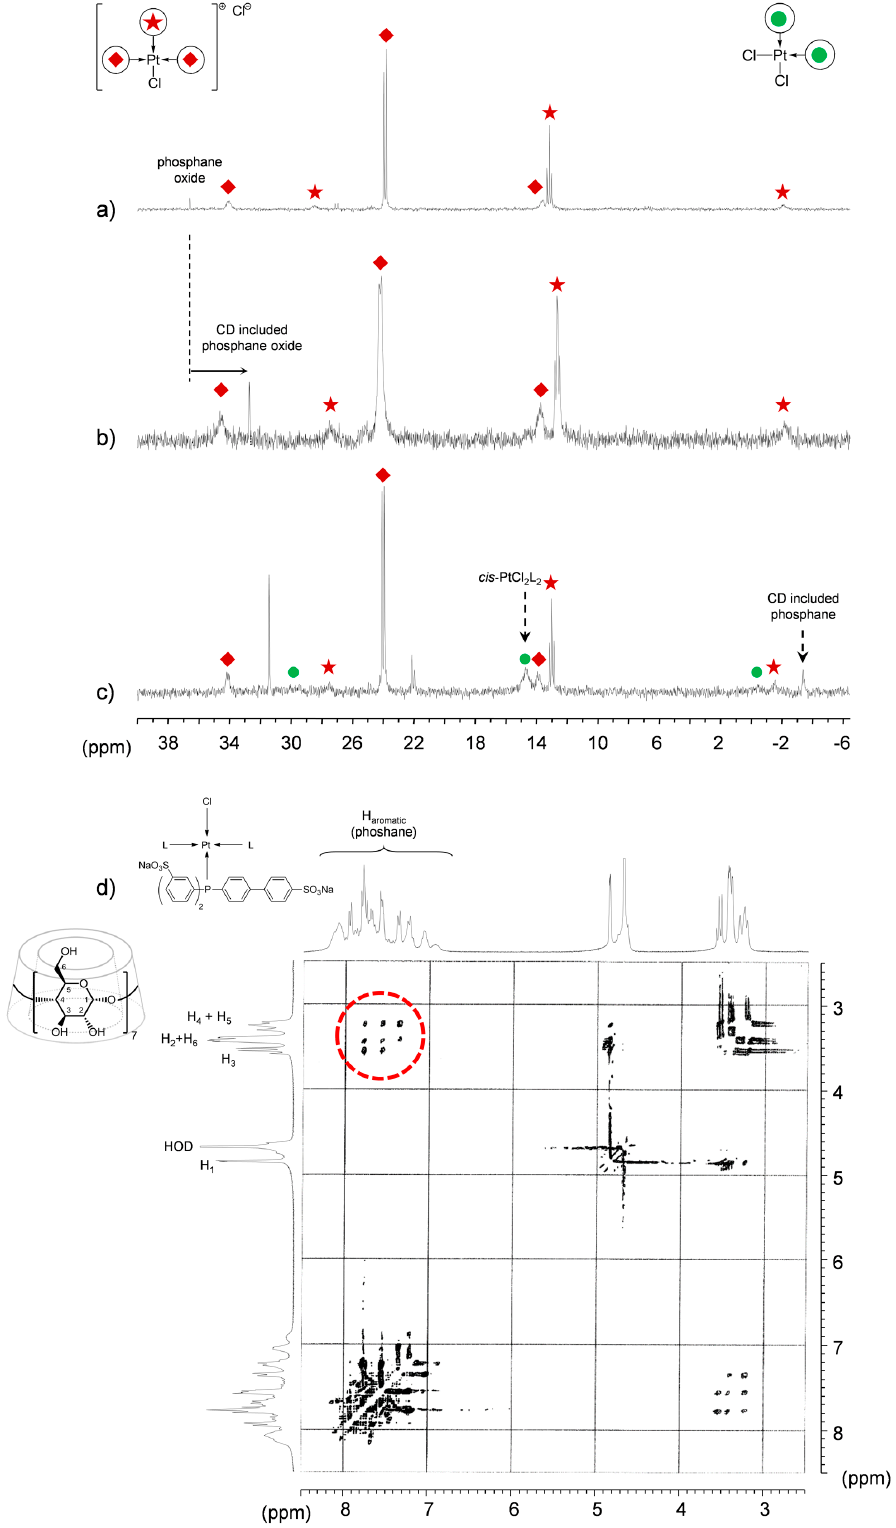
Figure 8. 31 P{ 1 H} NMR spectra of ( a ) [Pt(P(Biph)Ph 2 TS) 3 Cl]Cl 10 mM; ( b ) +3 equiv. of RAME- β -CD toward Pt at 25 °C ( c ) +12 equiv. of RAME- β -CD toward Pt at 85 °C ( d ) 2D T-ROESY spectrum of a solution containing β -CD (10 mM) and [Pt(P(Biph)Ph 2 TS) 3 Cl]Cl (10 mM) at 25 °C in D 2 O.